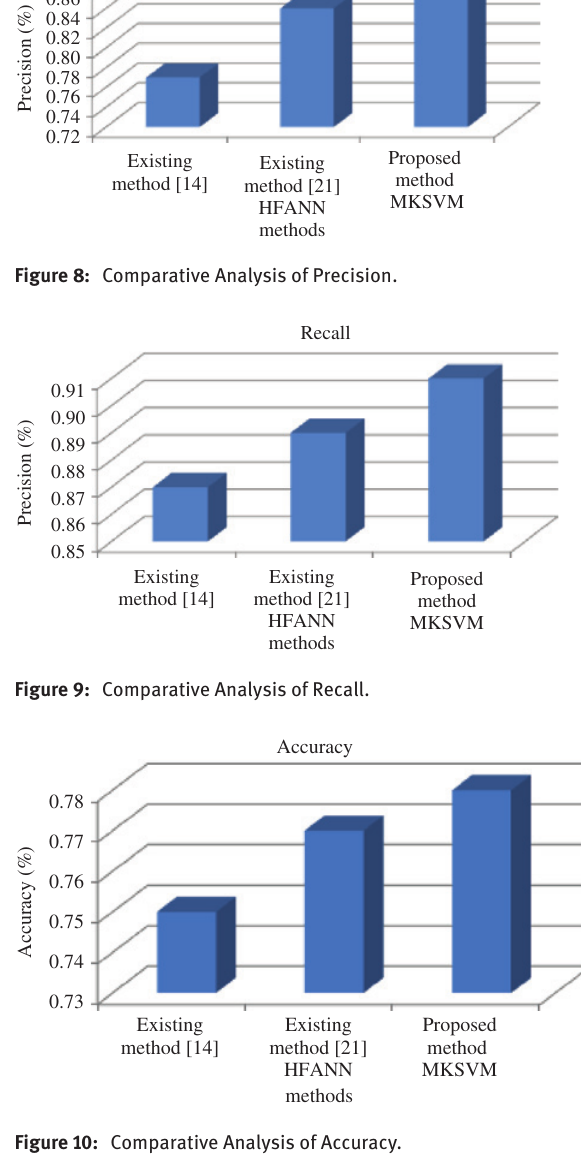
Figure 10: Comparative Analysis of Accuracy.